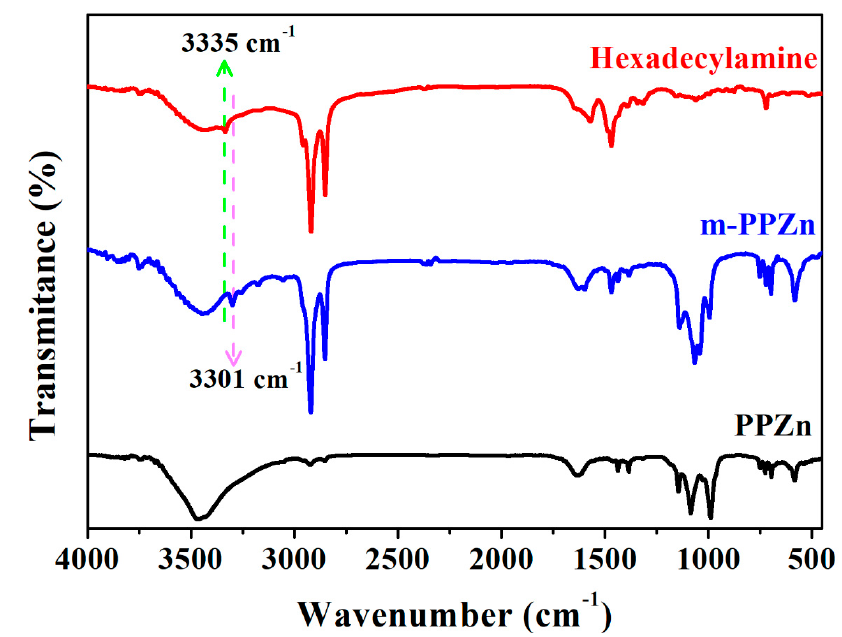
Figure 1. FTIR result of PPZn, m-PPZn, and hexadecylamine.